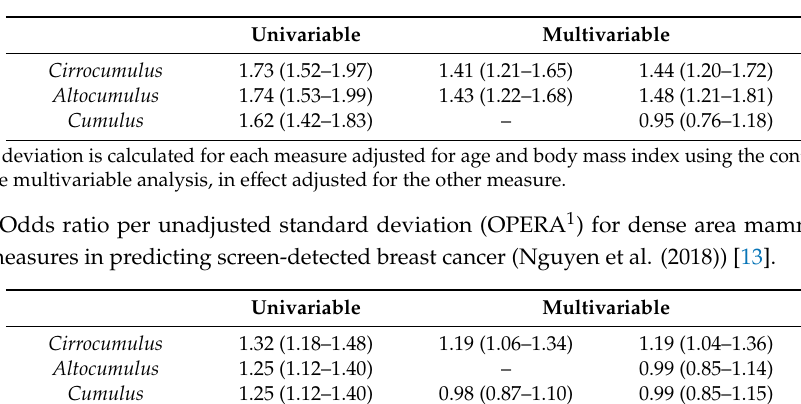
Table 1. Odds ratio per unadjusted standard deviation (OPERA 1 ) for dense area mammographic density measures in predicting younger age at diagnosis breast cancer for women with a family history of breast cancer (Nguyen et al. (2017)) [11].